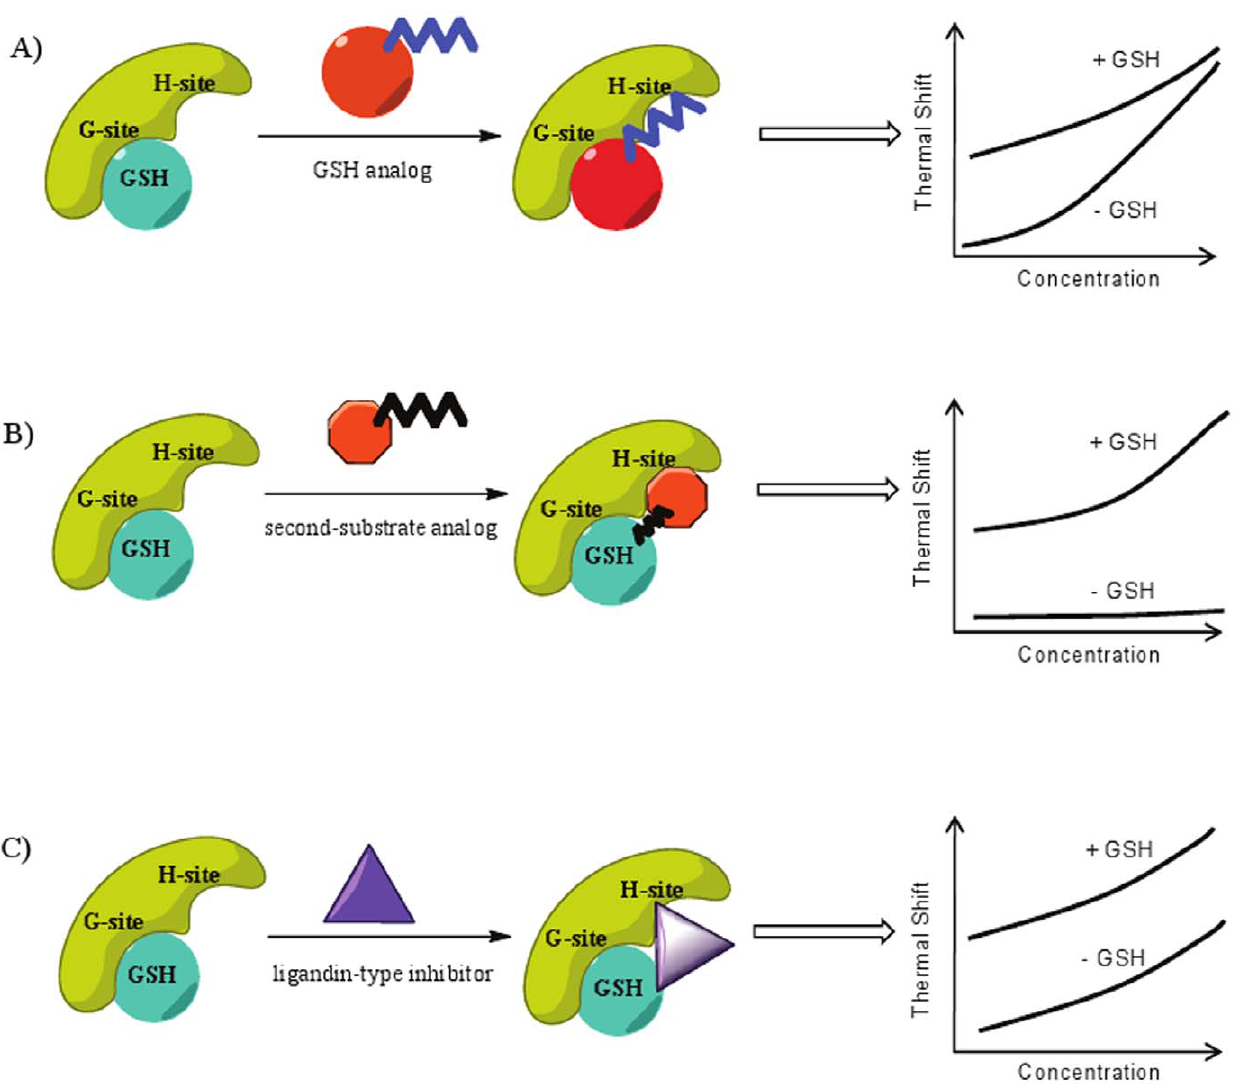
Figure 8. Schematic illustration of different inhibition mechanisms and the associated DSF signatures: A) GSH-competitive inhibition; B) conjugate-formation; C) ligandin-type.